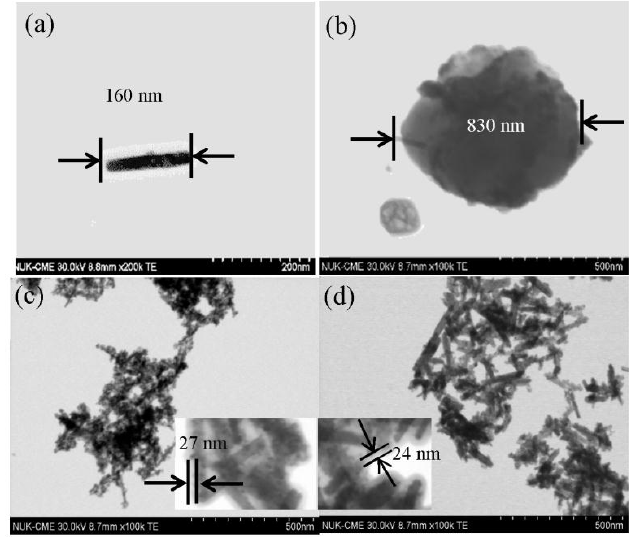
Figure 4. The transmission electron microscopy (TEM) images of ( a ) CNT; ( b ) PANi; ( c ) SGP3S3; and ( d )